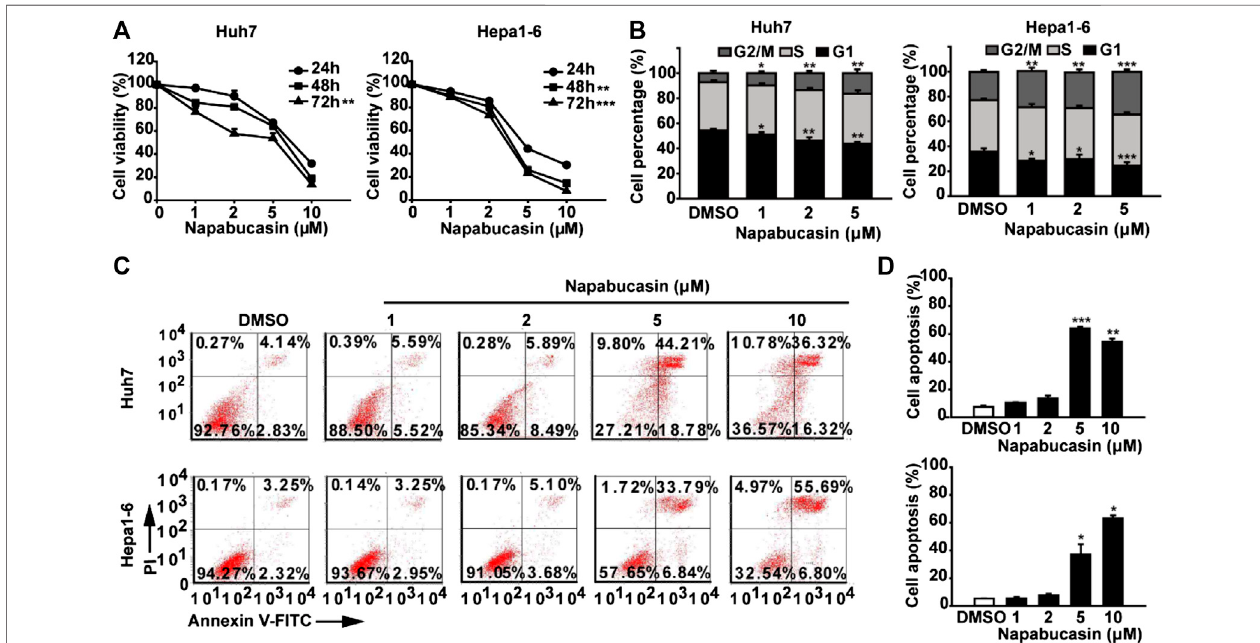
FIGURE 2 | Napabucasin induces the apoptosis and cell cycle arrest of HCC cells. (A) Viability of Huh7 and Hepa1-6 cells treated with DMSO or the indicated concentrations of napabucasin for 24, 48, and 72 h. (B) Cell cycle distribution of Huh7 and Hepa1-6 cells after treatment with DMSO or napabucasin for 24 h. The percentageofthecellsatdifferentphasesareshown. (C) Percentageofapoptotic Huh7andHepa1-6cellstreatedwithDMSOornapabucasinfor12 h.Dataareshown as mean ± SD of three independent experiments (* P < 0.05, ** P < 0.01 and *** P < 0.001).